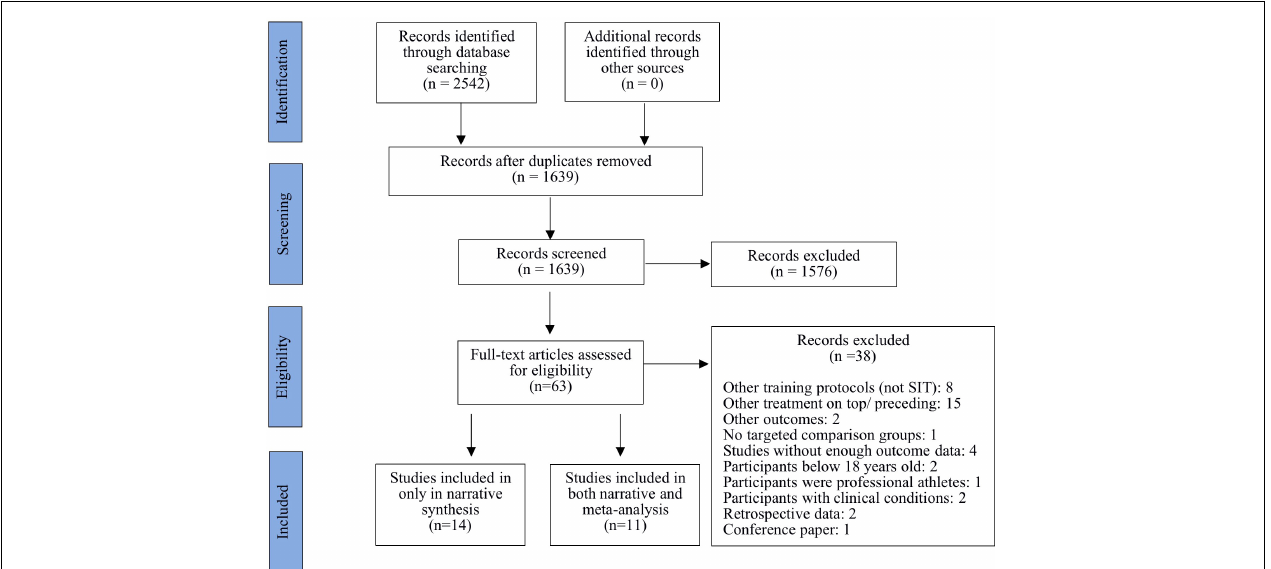
FIGURE 1 | Flow diagram of screening and selection of articles for